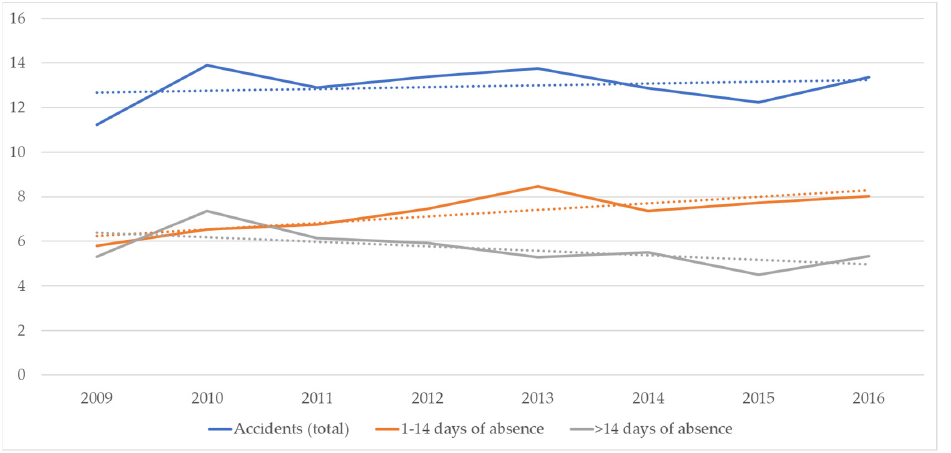
Figure 15. Incidence rates in various other specialised construction activities n.e.c. Based on data from [17 – 24,27].